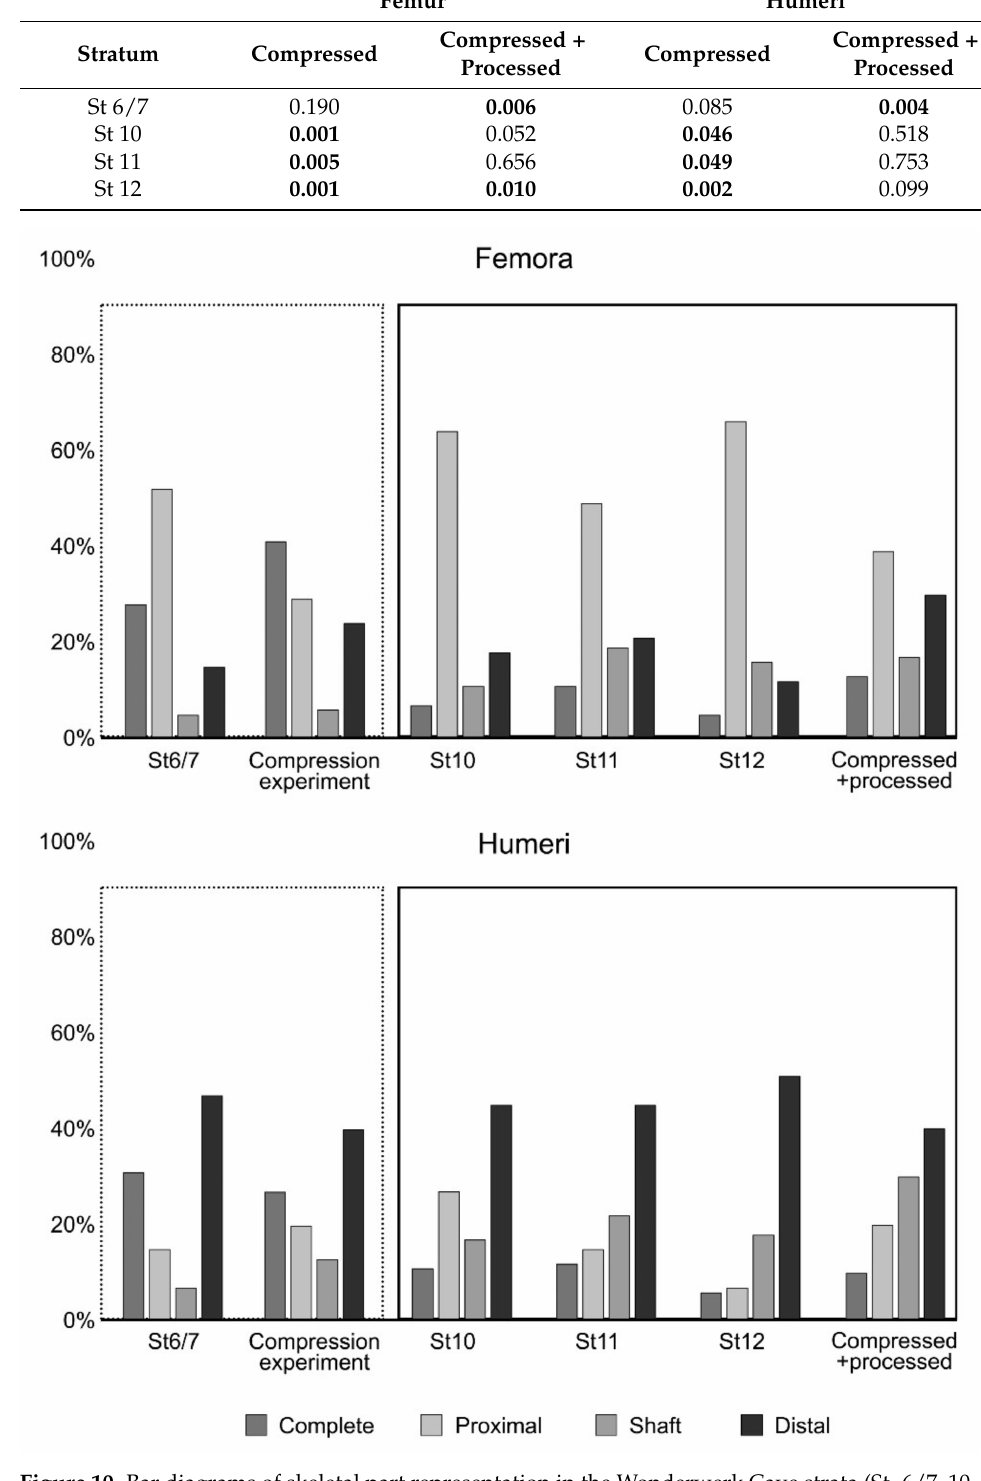
Figure 10. Bar diagrams of skeletal part representation in the Wonderwerk Cave strata (St. 6/7, 10, 11 and 12) compared to the fragments obtained in the compression experiment described